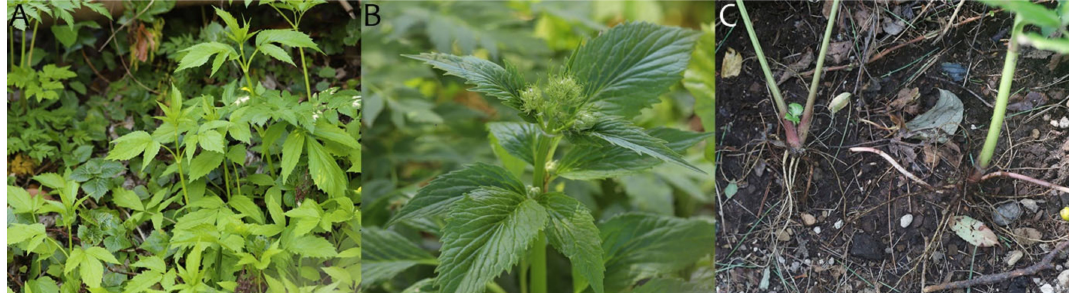
Figure 1. Valeriana sambucifolia f. dageletiana in its natural habitat on Ulleung Island, Korea. ( A ) General feature of entire plant; ( B ) Leaves and flower buds., ( C ) The base of stems and